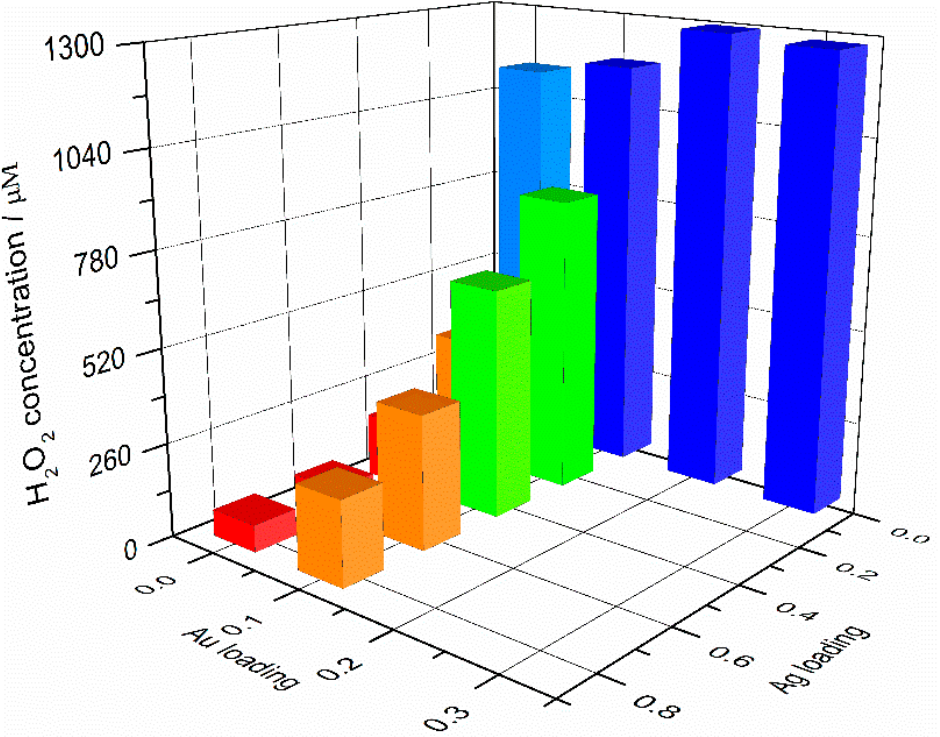
Figure 3. H 2 O 2 yield on ZnO loaded photocatalyst after one hour illumination (50 mg catalyst in 100 mL 0.1 M methanol solution).